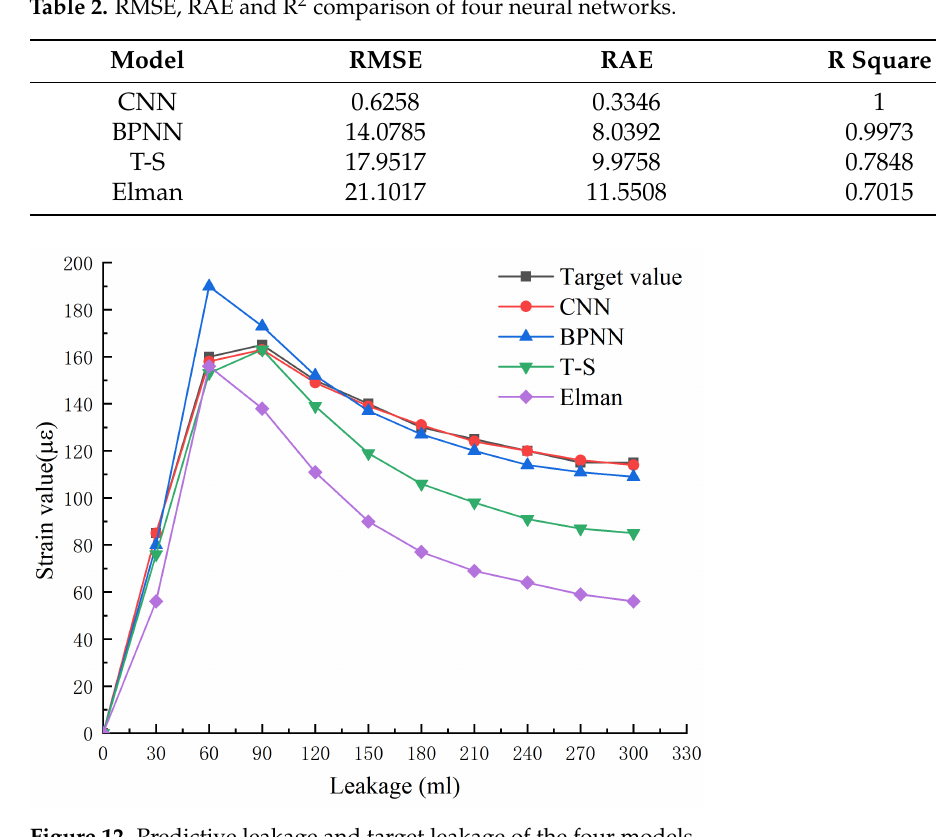
Figure 12. Predictive leakage and target leakage of the four